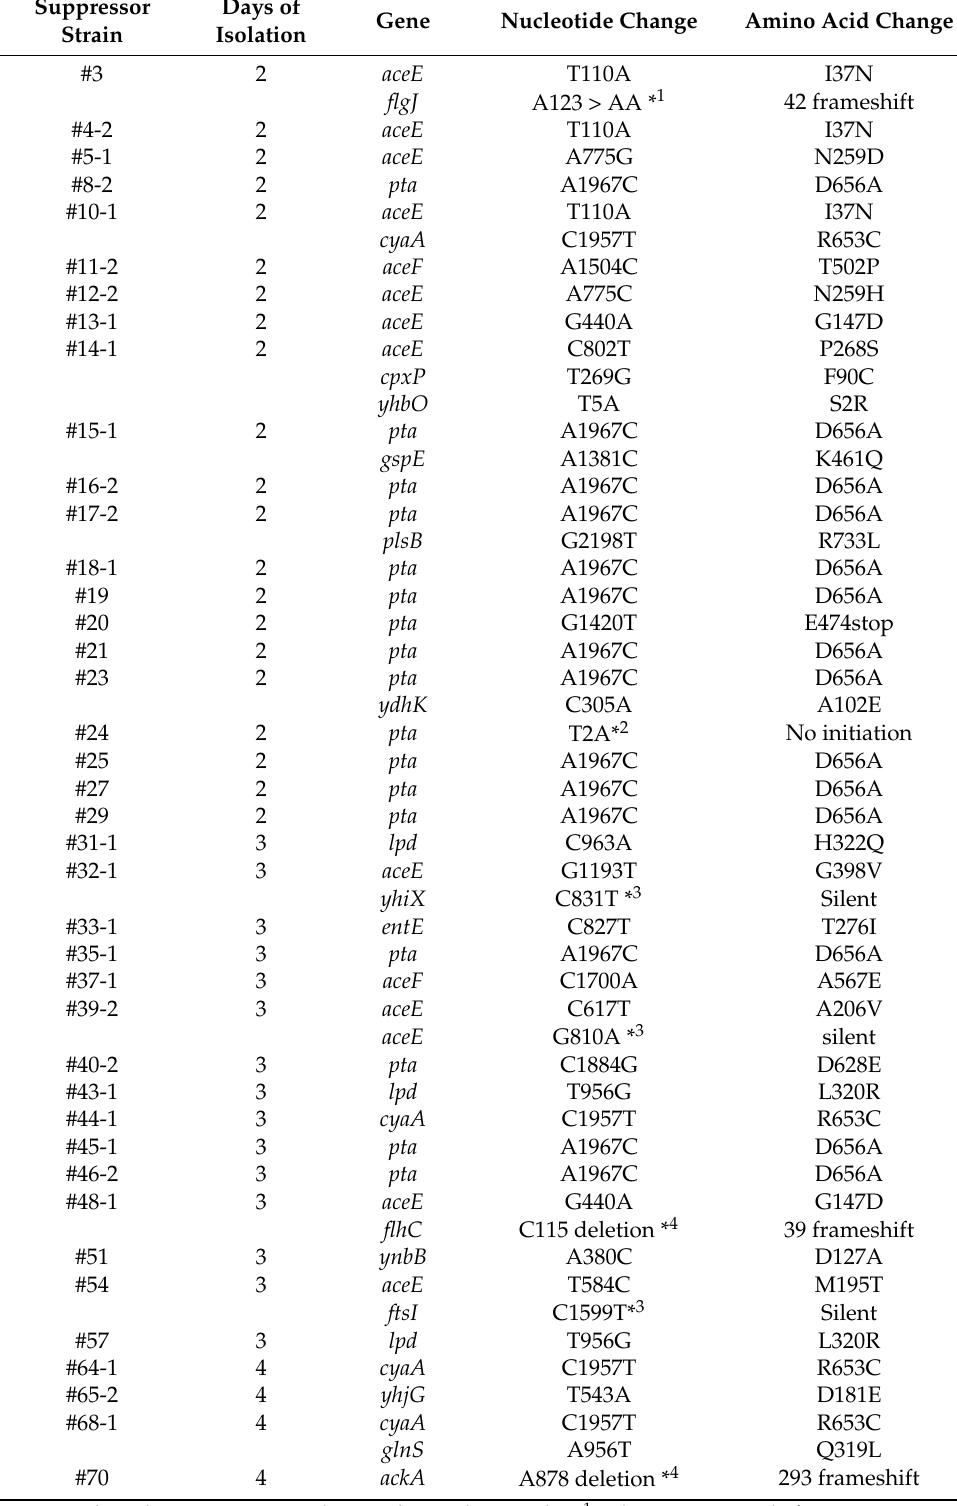
Table 3. Results of mutations in individual L-alanine prototrophic suppressor